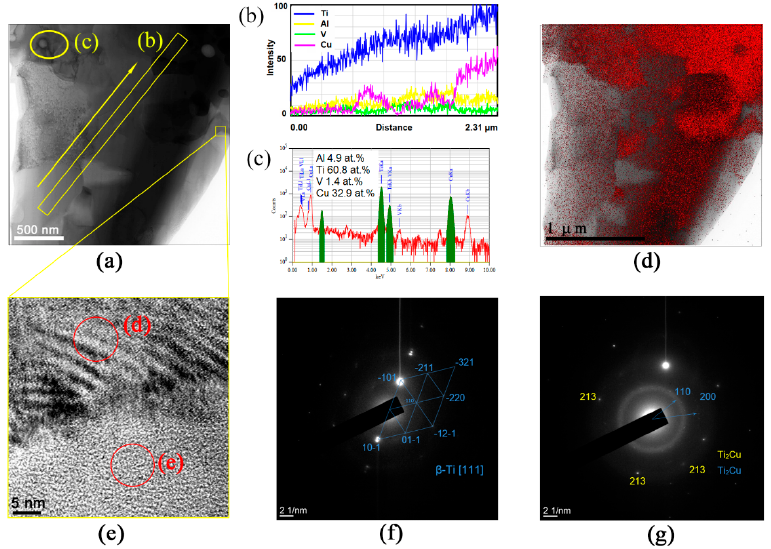
Figure 11. TEM bright-field image of the SZ2 microstructure ( a ) with a magnified fragment ( e ) containing the Ti 2 Cu/ β -grain boundary. ( b,c ) EDS spectra obtained along the lines shown in figure ( a ). ( d ) EDS distribution of copper atoms, ( f,g ) SAED patterns obtained from β grains and Ti 2 Cu, respec- tively.